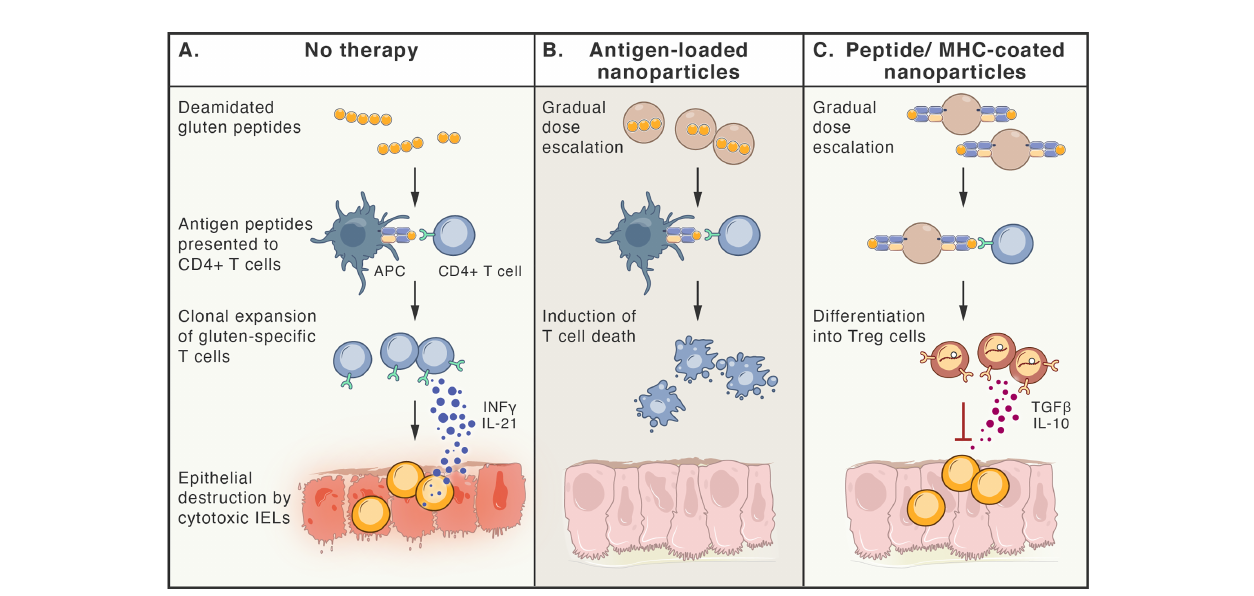
FIGURE 4 | Antigen-speci fi c therapies aiming at tolerance induction in celiac disease. (A). Peptides deriving from poorly digested gluten, enter lamina propria, where they are taken up by antigen presenting cells (APCs). Only HLA-DQ2 or -DQ8 molecules are able to bind antigenic gluten-deriving peptides and present them to gluten-speci fi c CD4 + T cells. These cells become activated, proliferate, release cytokines (e.g. IFN- g and IL-21) and migrate to the lamina propria, where they induce cytotoxic function of intraepithelial lymphocytes (IELs), that kill epithelial cells. (B, C). Therapy-induced tolerance is based on the gradual dose escalation of delivered gluten peptides (e.g. released from nanoparticles or bound to MHC molecules on nanoparticles). Presentation of antigens to gluten-speci fi c CD4 + T cells in a tolerogenic manner, leads to either death of these T cell clones (B) or their differentiation to Treg cells (C) , that are able to inhibit immune reaction by multiple ways, including release of TGF- b and